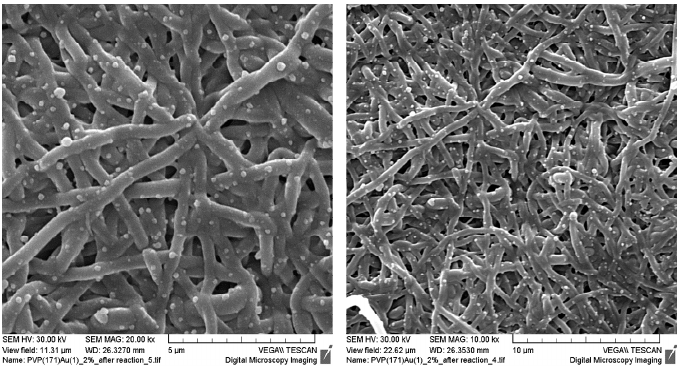
Figure 8. SEM images of the PVP/Au (2% wt) crosslinked membrane recovered after three reaction runs.